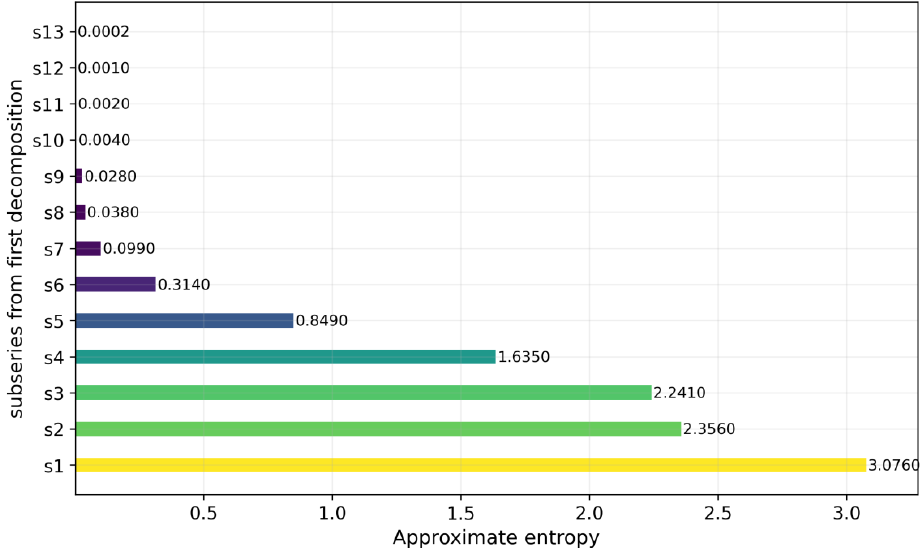
Figure 7. AE Figure 7. AE calculation.